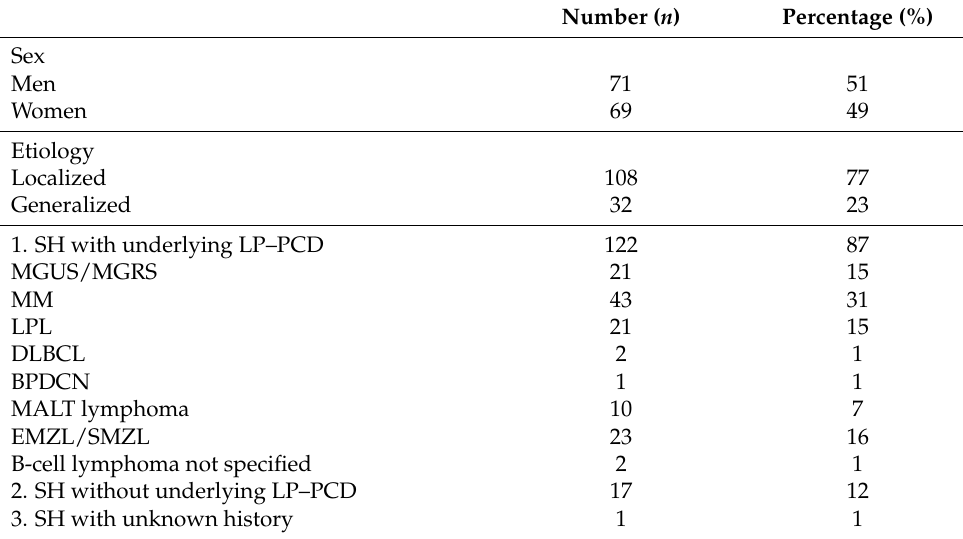
Table 3. Demographic and pathological data from identified cases.